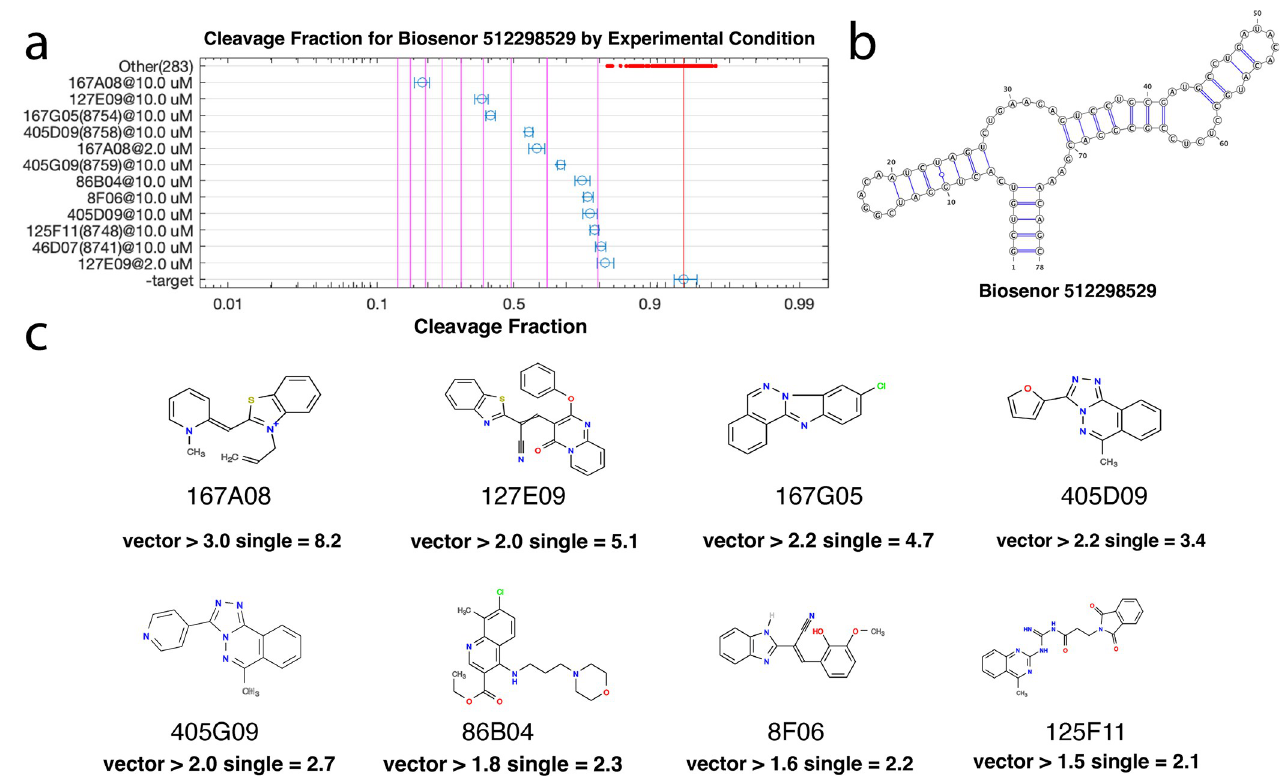
Fig 10. Promiscuous biosensors can sense multiple diverse ligands. For each cluster of sequences that have a similar response to the compounds, a representative sequence was chosen and shown along with its sequence (one particular sequence, 512298529, is shown above and the others in S1 File). (a) A chart of the cleavage of that sequence in the presence of each compound is then shown. Compounds that may give rise to a fold change that exceeds 2-fold (upper CI bound > = 2) are shown explicitly and all others that were individually measured are shown by the red points at the top of the chart. Error bars indicate the 95% confidence interval based on read count statistics. Vertical lines indicate the fold change of cleavage from the no ligand condition. (b) Predicted secondary structure of 512298529. (c) The chemical structure of each compound with fold change > = 2.0 is also shown. The measured fold change of cleavage are listed below each compound, as derived from either single-compound measurements (“single”) and as an lower-bound estimate o from the measurement of fold change of cleavage from the 256-compound vectors